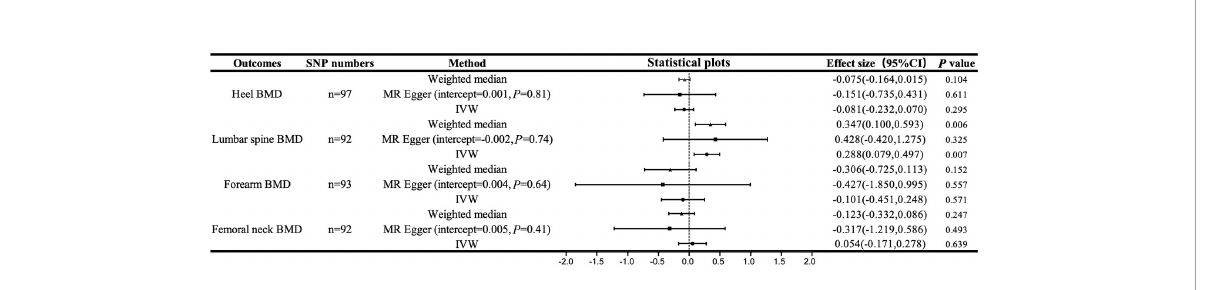
FIGURE 2 Casual associations between hand grip strength and BMD. IVW, inverse variance weighted; MR Egger, mendelian randomization egger; CI, con fi dence interval; BMD, bone mineral density; SNP, single nucleotide polymorphism.